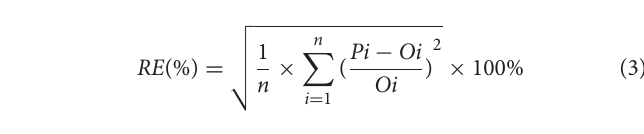
FIGURE 5 | Contour maps of coefficients of determination between aerial N uptake and the mRPA with formula (R λ 1 /R λ 2 ) 1 / 2 × (R 760 -R 718 ) ( n = 155, p 0.001 = 0.262).